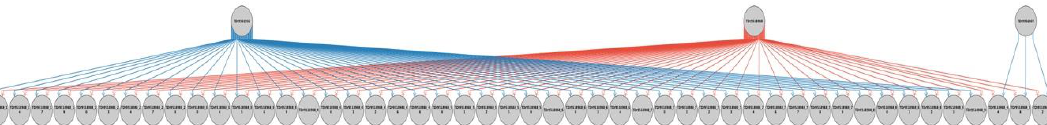
Figure 8. Pedigree reconstruction of polycross family TDr1691 based on Helium pedigree visualization. TDr9501932 and TDr9902607 = male parents (blue); TDr9518988 = female parent (red).